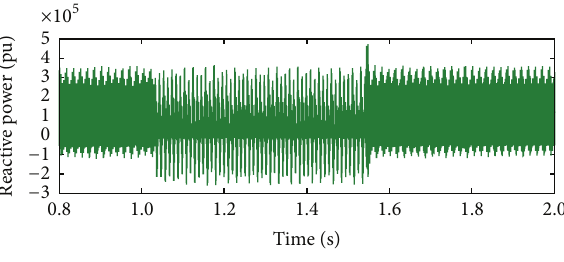
Figure 11: Reactive power during L-L fault.